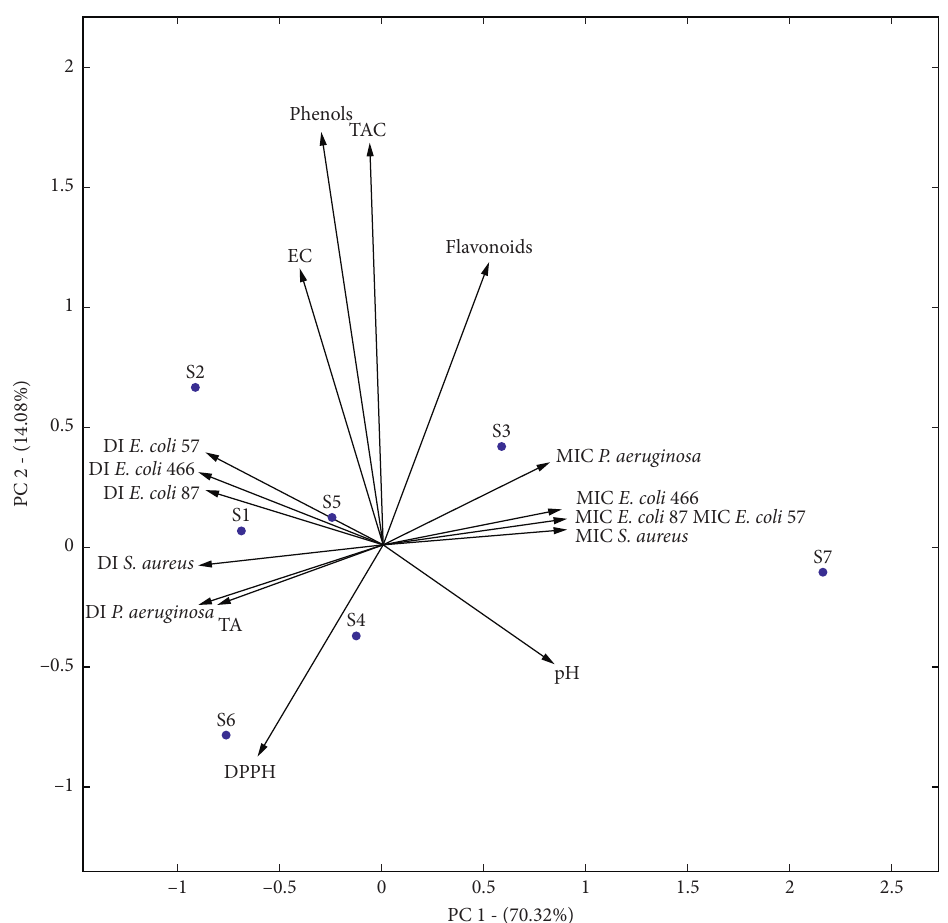
Figure 1: Principal component analysis (PCA) of the analyzed vinegar samples using the assessed parameters as an input: phenols, flavonoids, IC 50 , DPPH, and pH. TAC: total antioxidant capacity; TA :total acidity; EC :electrical conductivity; DI :diameters of the inhibition zones; MIC :minimum inhibitory